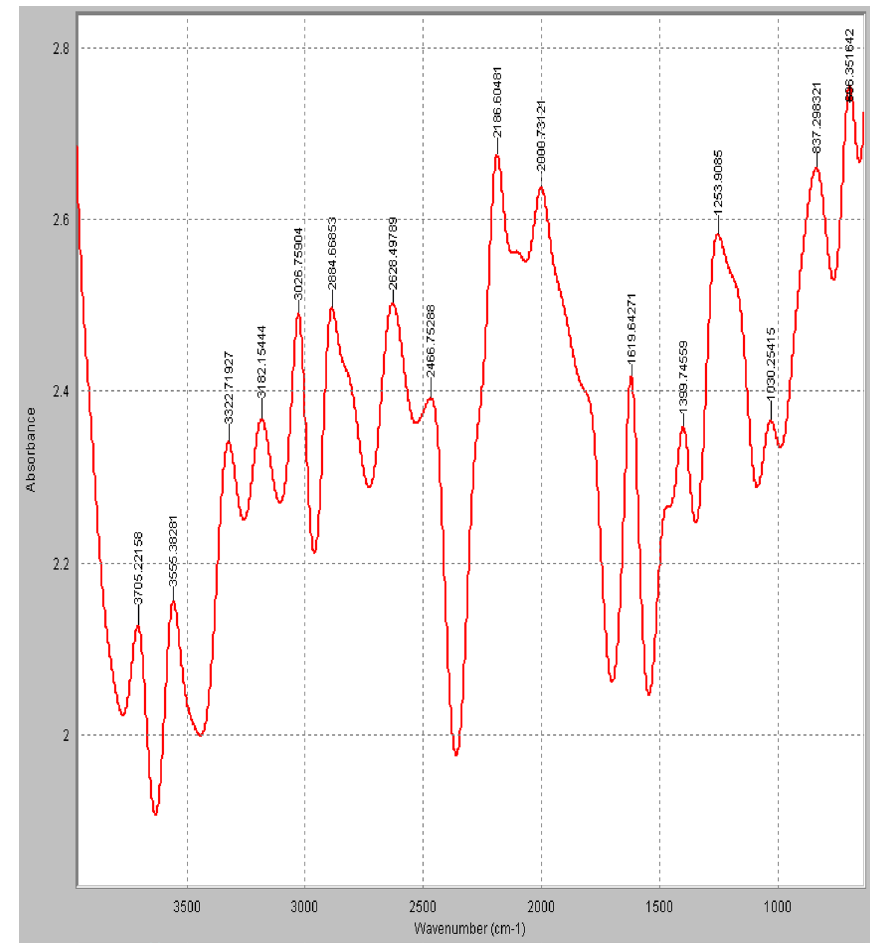
Fig. 3 FTIR spectrum analysis of AESA biosorbent before adsorption of